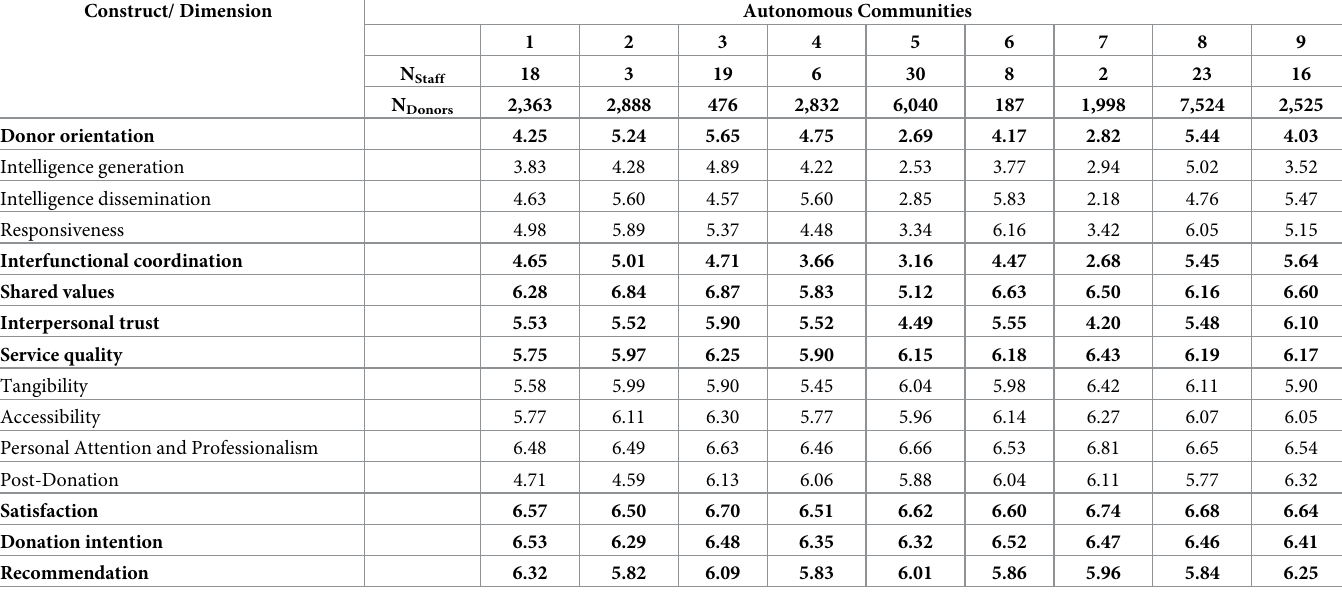
Table 5. Mean values of the constructs by autonomous